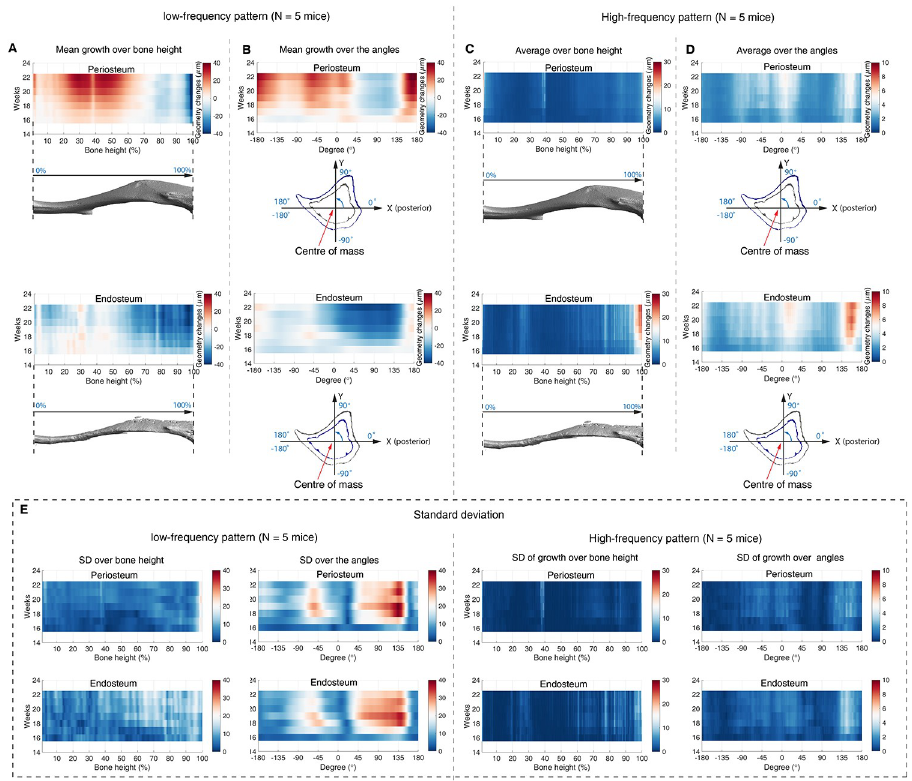
Fig 6. Spatial-temporal analysis of bone geometry changes of a wild-type mouse tibia. (A-B) The spatially averaged low-spatial frequency activity patterns from week 14 to 22. (C-D) The spatially averaged high-spatial frequency activity patterns from week 14 to 22. The averaged pattern over bone height are shown in sub-figures A and C (top: periosteum, bottom: endosteum). The averaged pattern over angles are shown in sub-figures B and D (top: periosteum, bottom: endosteum). (E) The corresponding SD maps of the sub-figures (A-D)(N = 5 mice).